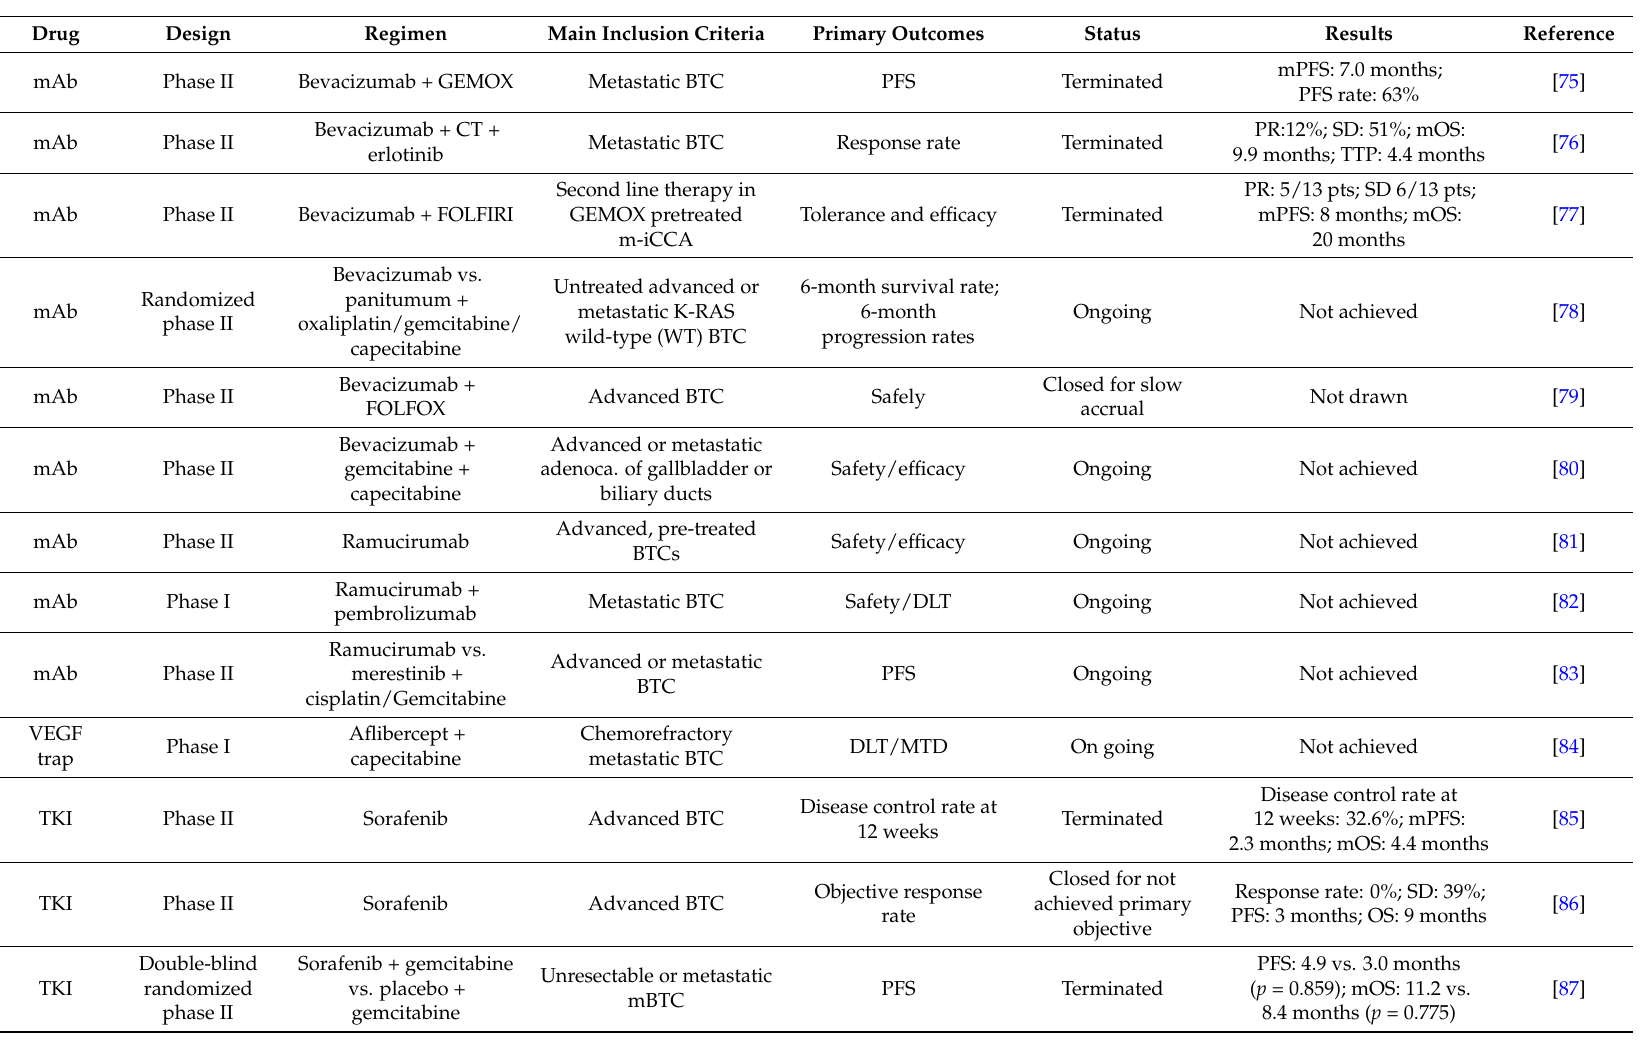
Table 2. Clinical trials of anti-angionenic drugs in